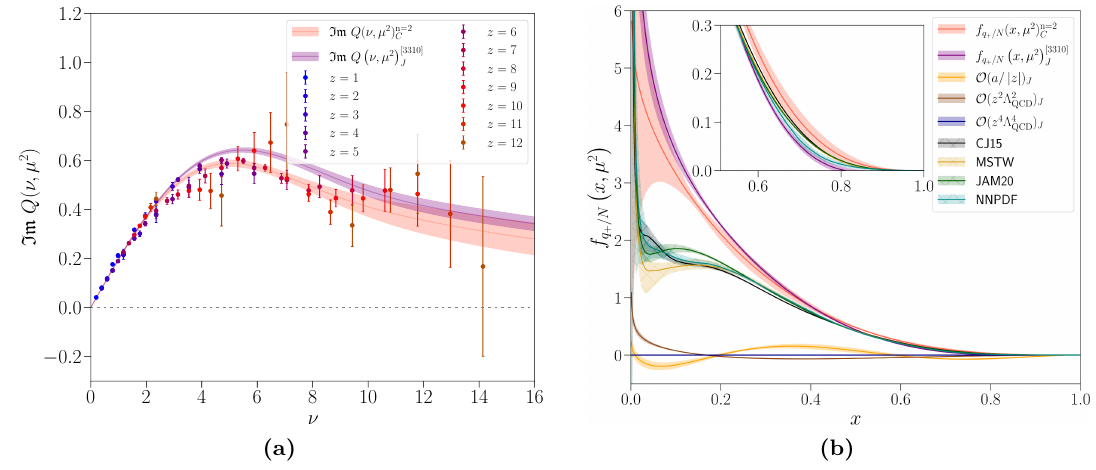
Figure 19. (a) The imaginary component of the leading-twist ITD (purple) at 2 GeV derived from the Jacobi polynomial expansion of the reduced pseudo-ITD for z/a ≤ 12 with { n { 3 , 3 , 1 , 0 } + . The result is compared with the uncorrelated 2 -parameter phenomenological form of eq. (4.8) shown in red. (b) The plus quark leading-twist PDF (purple) obtained from the { n lt , n az , n t 4 , n t 6 } + = { 3 , 3 , 1 , 0 } + Jacobi polynomial expansion of the reduced pseudo-ITD. The a/ | z | (orange) and twist- 4 (brown) x -space distributions are also shown and seen to be sub-leading. The distributions are compared with the uncorrelated 2 -parameter phenomenological fit of eq. (4.8) (red), as well as the NLO global analyses of CJ15 [82] and JAM20 [88], and the NNLO analyses of MSTW [89] and NNPDF [87] at the same